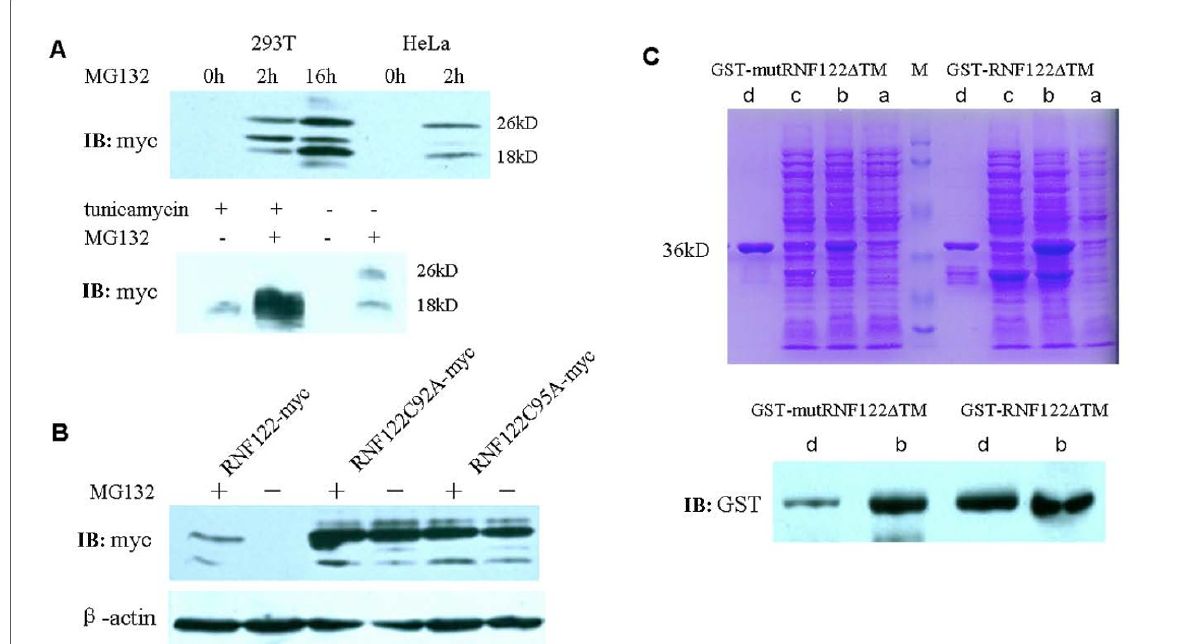
Figure 1 Characterization of RNF122 expression in mammalian and E. coli cells. (A). HEK293T and HeLa cells were transiently transfected with RNF122-myc. At 24 h post-transfection, the cells were treated with 2.5 μg/mL MG132 or 50 μg/mL tunicamycin and harvested at the indicated time. The cell lysates were subjected to SDS-PAGE and analyzed by western blotting using anti-myc and anti-β-actin antibodies. (B). HEK293T cells were transiently transfected with RNF122-myc or with RNF122C92A-myc or RNF122C95A-myc mutants. At 24 h post-transfection, the cells were treated with 50 μg/mL MG132, harvested after 6 h, and then analyzed by western blotting. (C). GST-RNF122ΔTM or GST-RNF122-ΔTM mutant proteins were expressed in E. coli and purified by affinity chromatography. The proteins were verified by SDS-PAGE and western blotting using an anti-GST